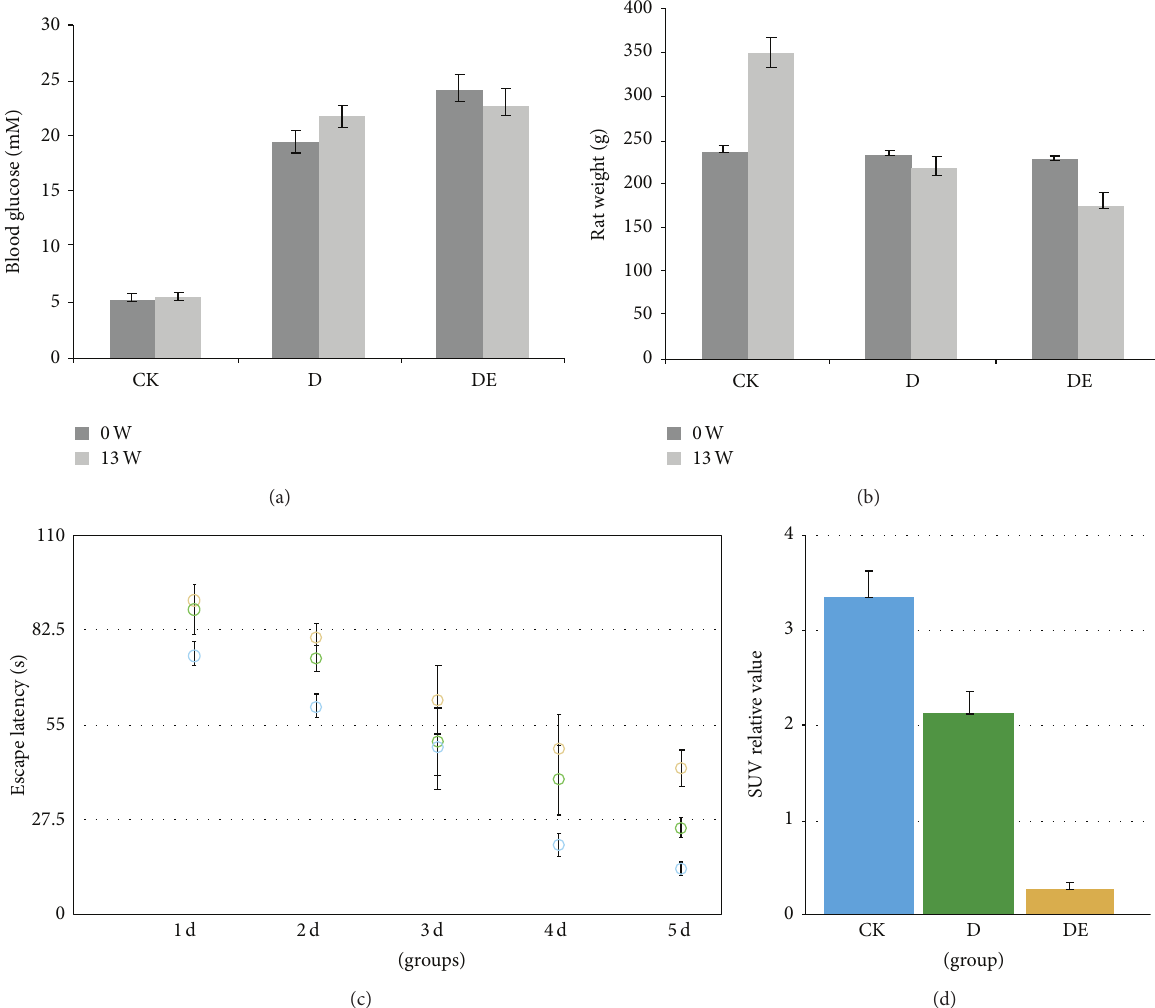
Figure 1: Blood glucose (a) and body weight (b) of mice in 3 groups. The ability analysis of learning and memory of mice in 3 groups (c). Evaluation of brain glycometabolism in DE animals by PET/CT